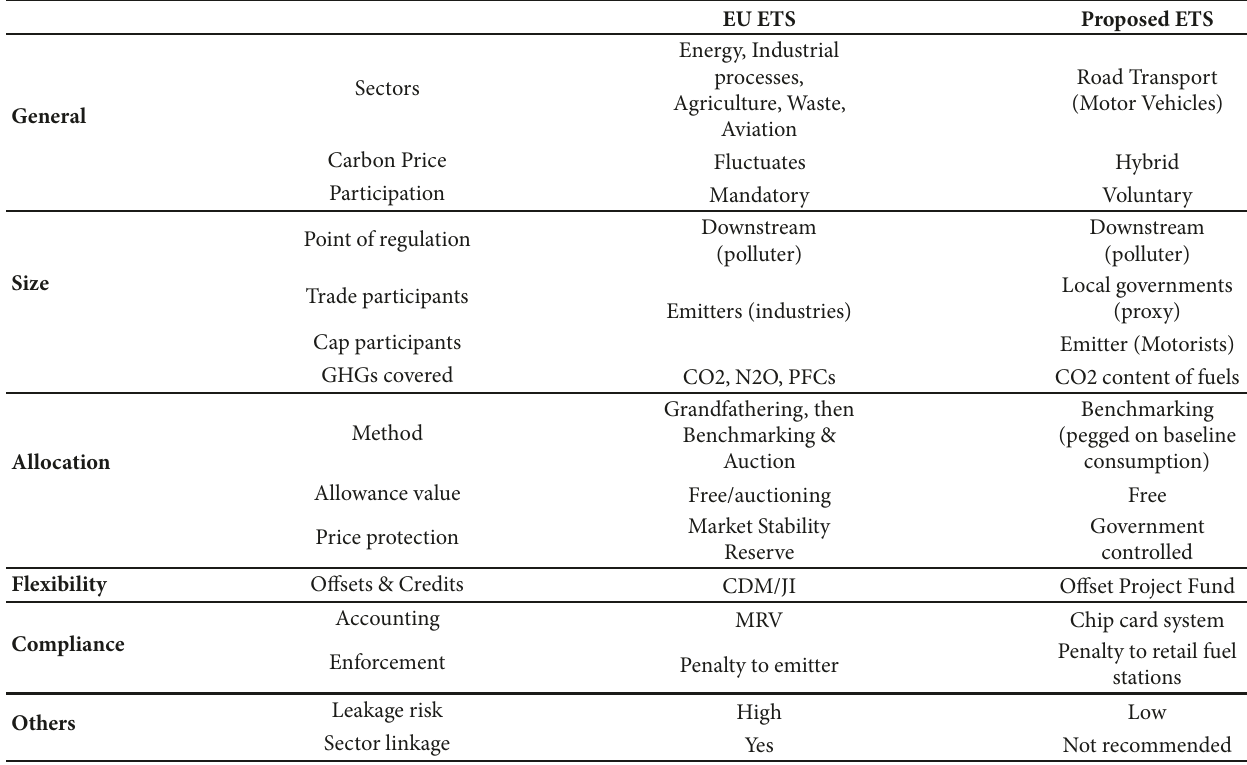
Table 1: The proposed Scheme features compared with the EU ETS.